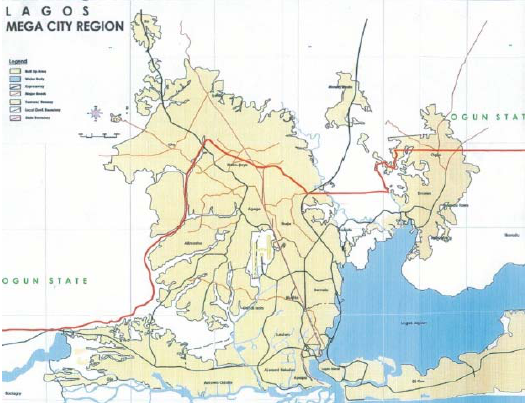
Figure 1: The Lagos Megacity Region (Source: Redevelopment of Megacity Region Report, 2006)